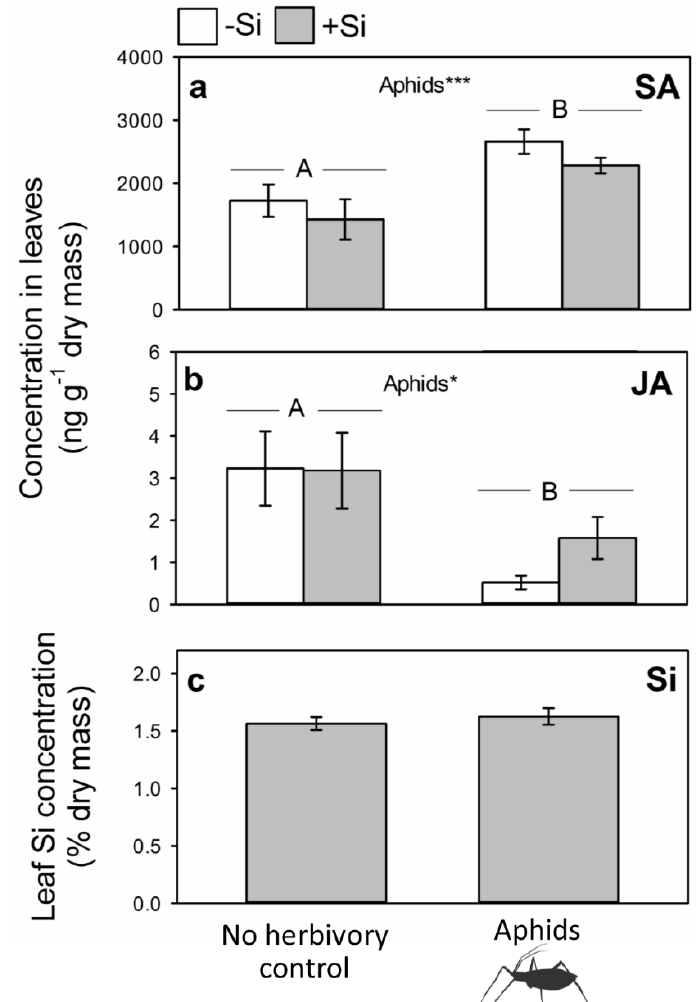
Figure 2. Leaf concentrations of ( a ) salicylic acid (SA), ( b ) jasmonic acid (JA) in − Si and + Si plants and ( c ) Si ( + Si plants only) subjected to aphid herbivory prior to feeding by caterpillars. Results of statistical analysis ( a ) Si: F 1,28 = 2.08, p = 0.160; Aphids: F 1,28 = 14.61, p < 0.001; Si × Aphids: F 1,28 = 0.03, p = 0.861; ( b ) Si: χ 1,28 = 0.12, p = 0.726; Aphids: χ 1,28 = 6.21, p = 0.013; Si × Aphids: χ 1,28 = 0.03, p = 0.142 and ( c ) Aphids: F 1,28 = 0.46, p = 0.504. Significant treatments indicated *** p < 0.001 and * p < 0.05 and uppercase letters used to indicate differences between treatments. Mean ± SE shown.